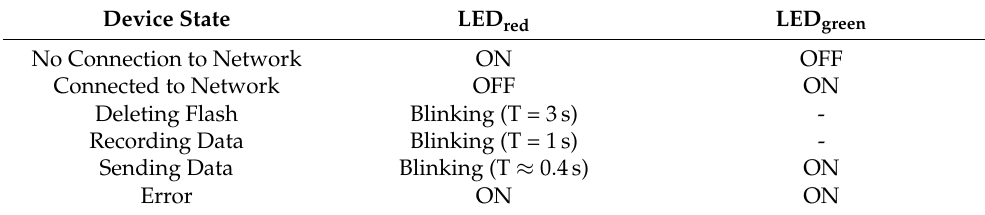
Table 1. SPECTRE 3.0 indicator LED behaviour in relation to the device state. Device State LED red LED green No Connection to Network ON OFF Connected to Network OFF